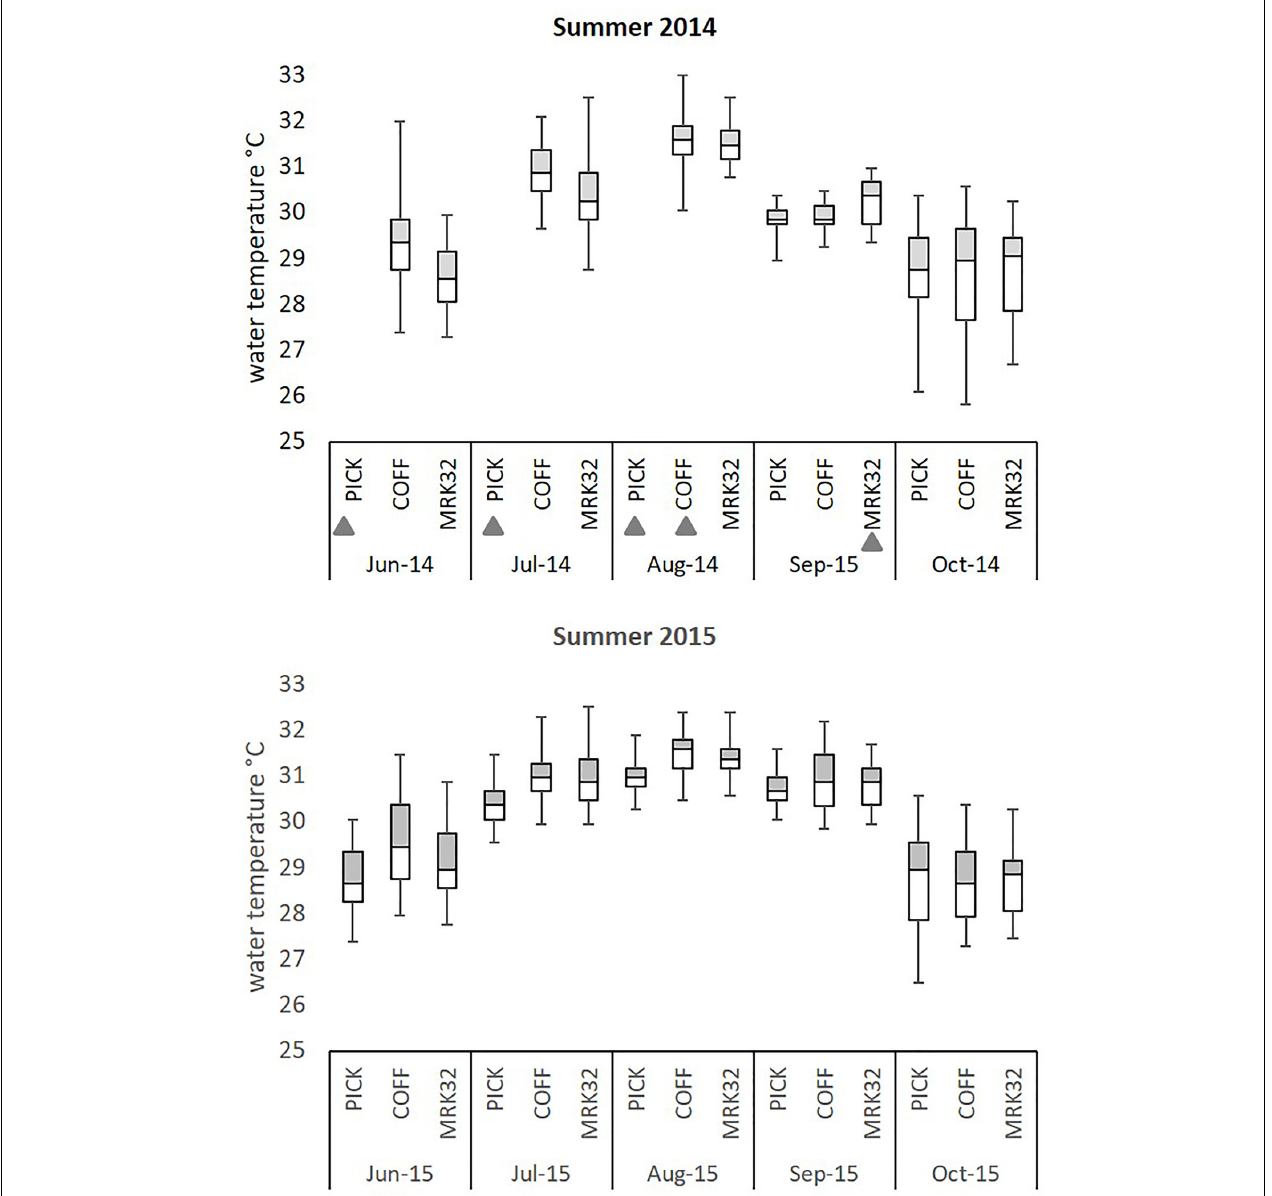
FIGURE 4 | Summary of water temperature profiles at three sites on the Florida Reef Tract during summer 2014 and 2015. Five-number summary of temperature profiles at three sites (Pickles: Upper, Coffins: Middle, Marker 32: Lower) along the Florida Reef Tract. Hourly water temperatures from pendant data loggers were used to create temperature profiles from June through October 2014 and 2015. Box plots indicate interquartile temperature ranges (Q2–Q3) and median temperatures. ‘Whiskers’ show maximum and minimum water temperature during this time period. Gray triangles indicate incomplete temperature profiles due to lost data